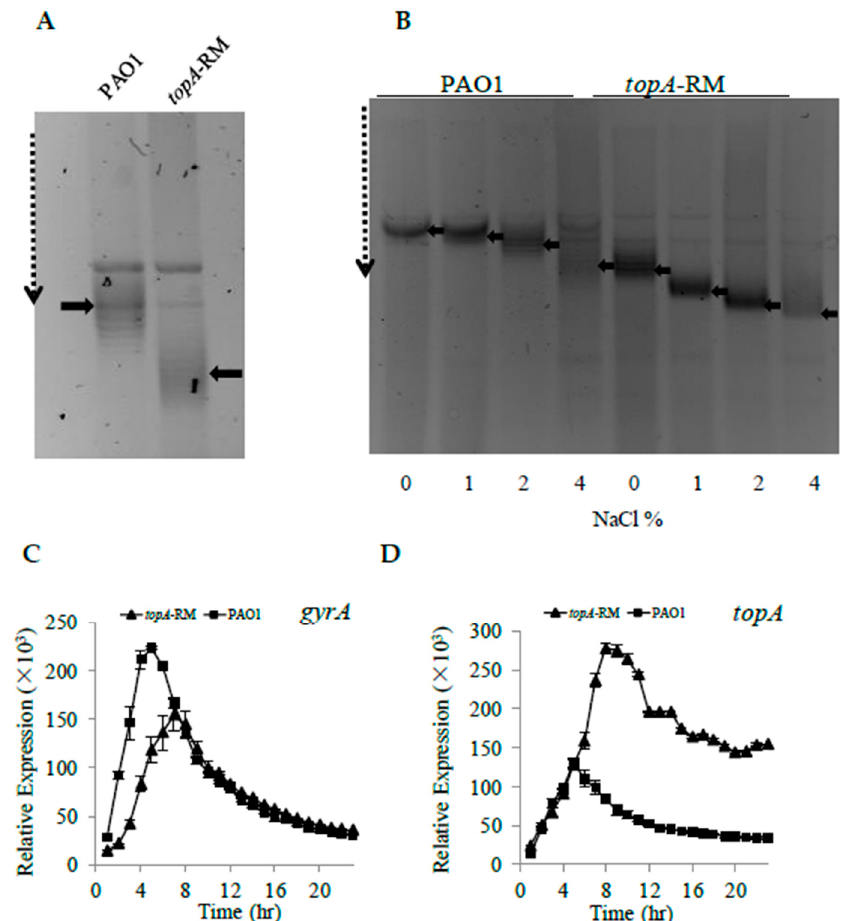
Figure 6. The DNA topological changes in topA -RM. ( A ) Higher DNA supercoiling level in topA -RM than in PAO1. The plasmid pUCP26 isolated from each strain was separated on 1% agarose gel containing 5 µ g/mL chloroquine. Solid arrows indicate supercoiled plasmid; the dashed arrow points increased negative supercoiling levels. ( B ) Enhanced DNA supercoiling with increasing NaCl concentrations. Cells were treated at different concentration of NaCl for 3 h before plasmids were isolated. Topoisomers of plasmids from different treatments were analyzed by the chloroquine gel electrophoresis. ( C , D ) The expression profiles of gyrA ( C ) and topA ( D ) were measured using p- lux reporter system. The expression levels are presented as cps normalized to OD 595, and the values in topA -RM are shown as triangles and those in PAO1 as squares (data shown as averages from triplicate experiments ± standard errors of the